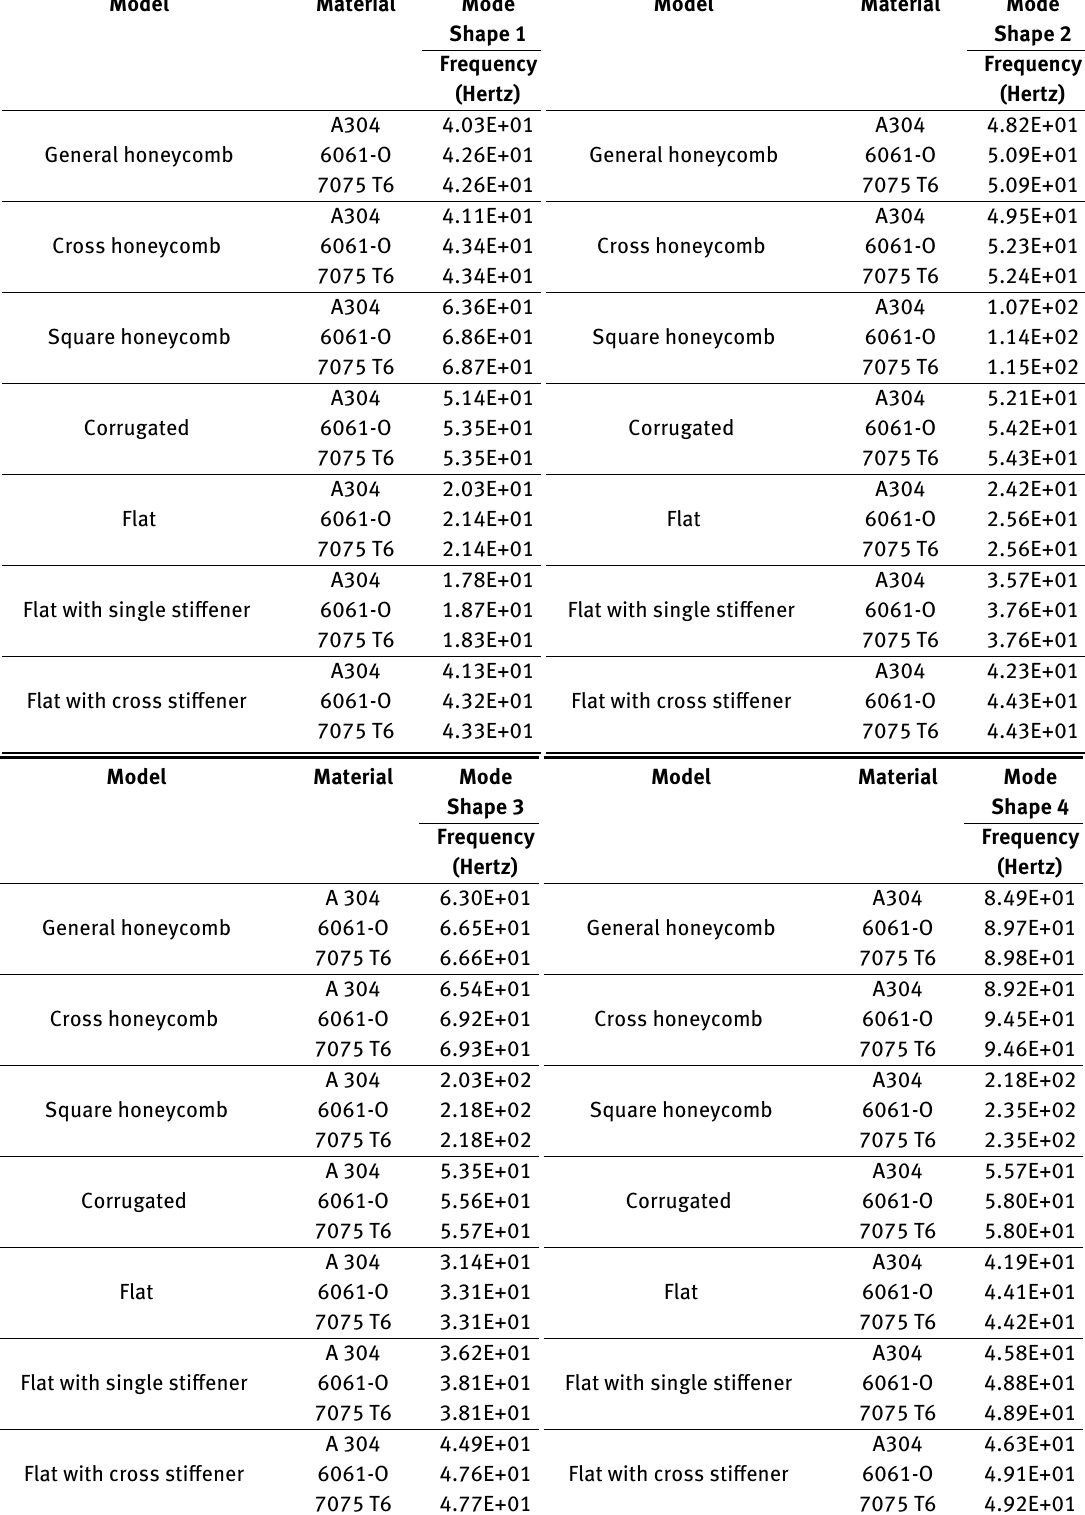
Table 11: Summary of the vibration